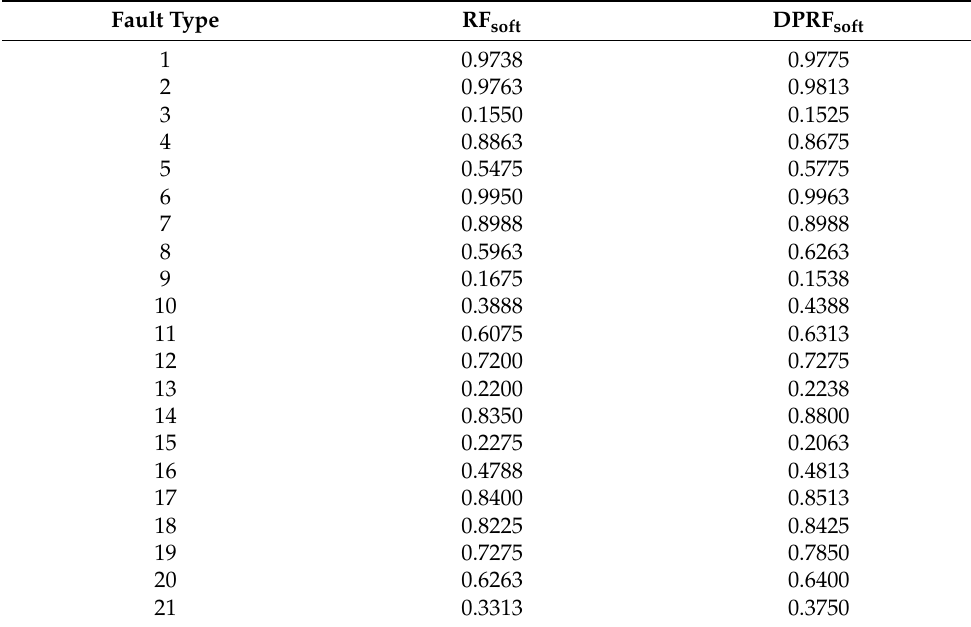
Table 5. LACC values of RF and DPRF based on soft voting rules (missing rate = 0.1).